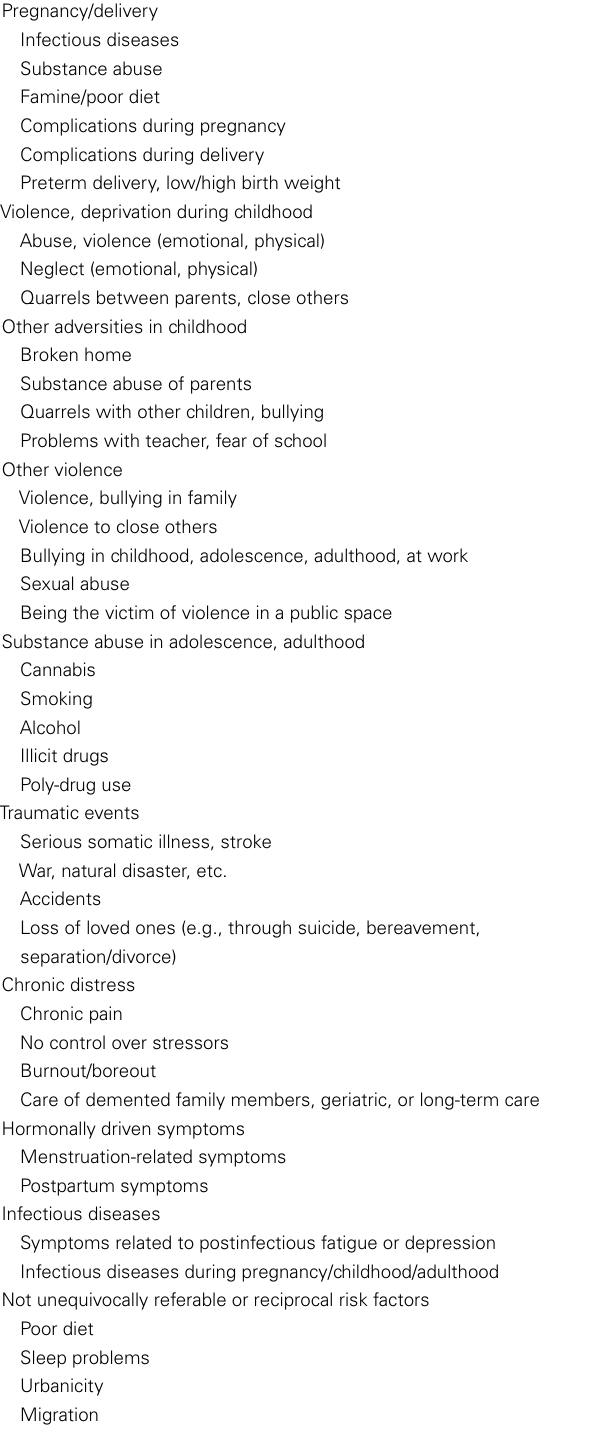
Table 1 | Risk factors for mental disorders